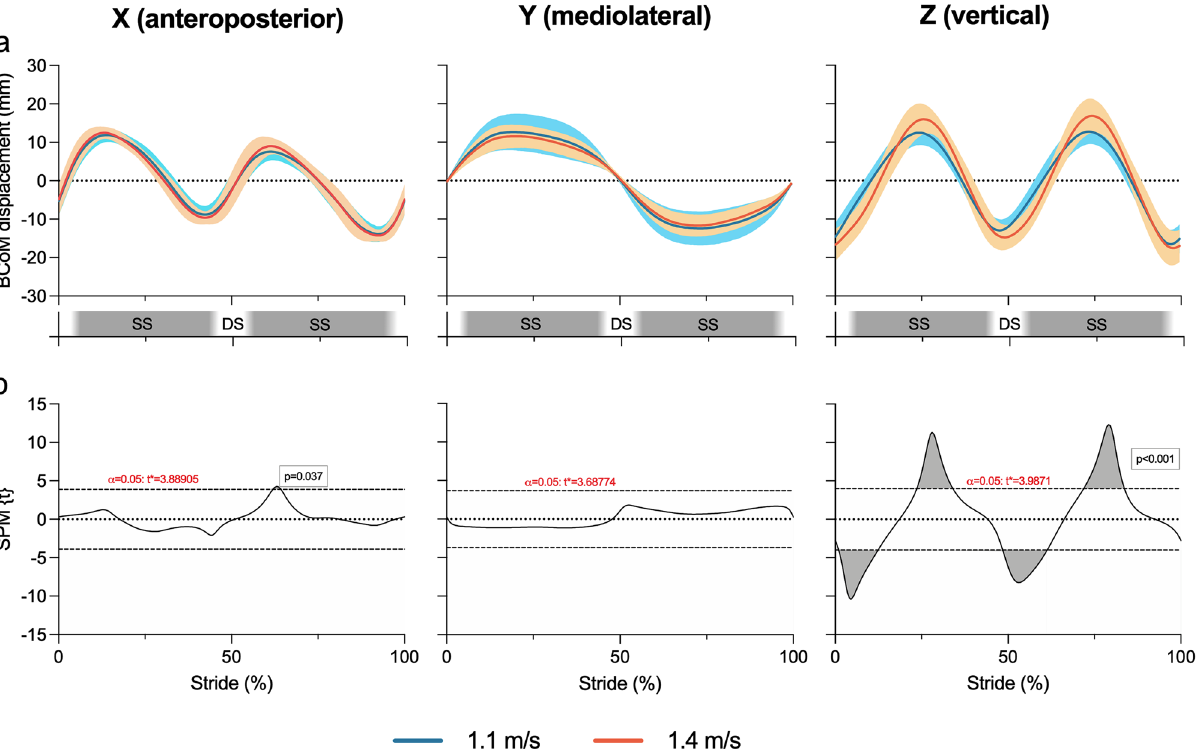
Figure 4. Anteroposterior (x), mediolateral (y) and vertical (z) trajectories of the BCoM at 1.1 and 1.4 m/s ( a ) and corresponding SPM paired two-tailed t-test with an alpha level of 0.05 ( b ). For graphical purposes, the horizontal axis spans from 0 to 100% of the stride period, instead of spanning from 0 to 2π as required by Fourier analysis. In panel a, approximate double support (DS) and single support (SS) periods are shown to ease the understanding of the